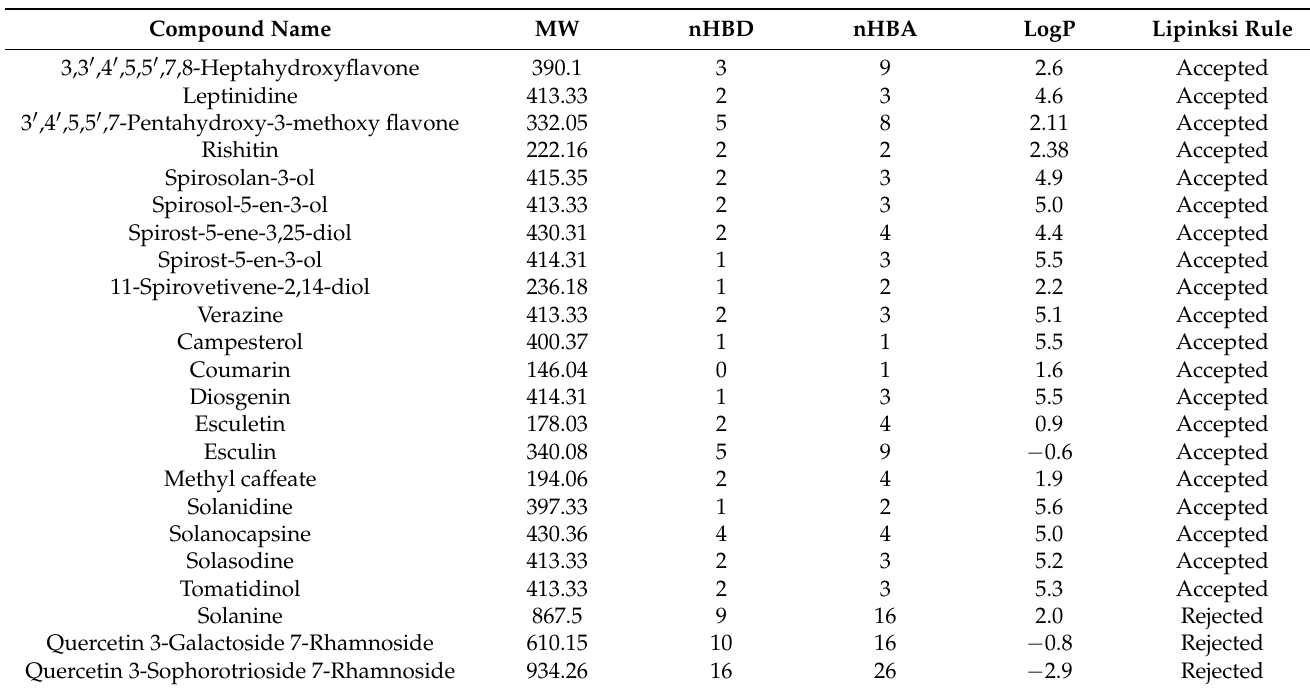
Table 1. Properties of active